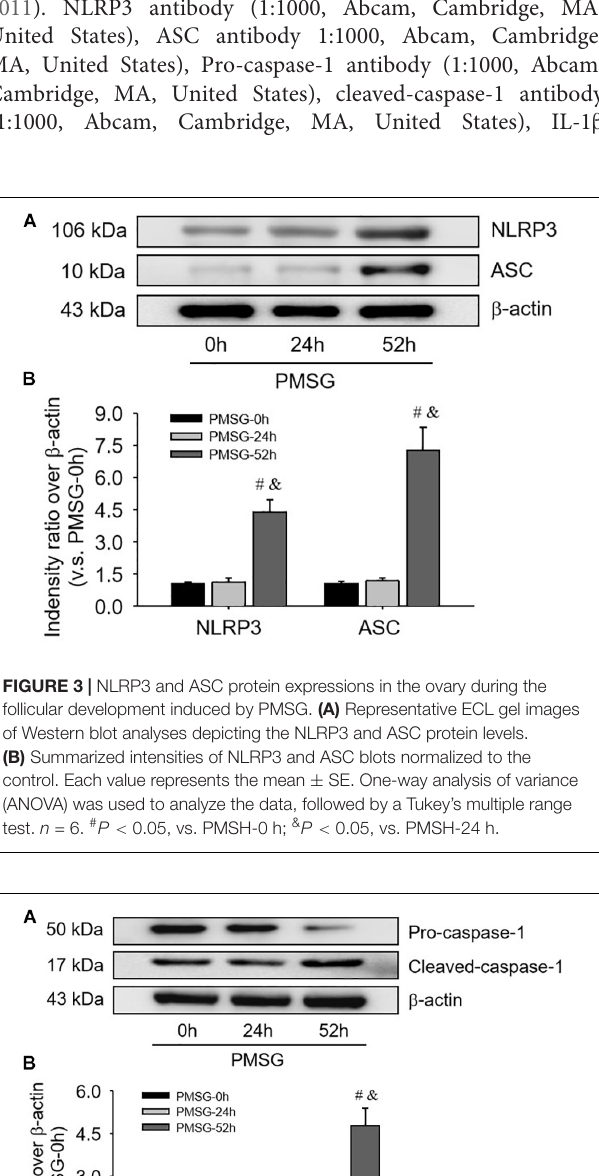
FIGURE 4 | Pro-caspase-1 and cleaved-caspase-1 protein expressions in the